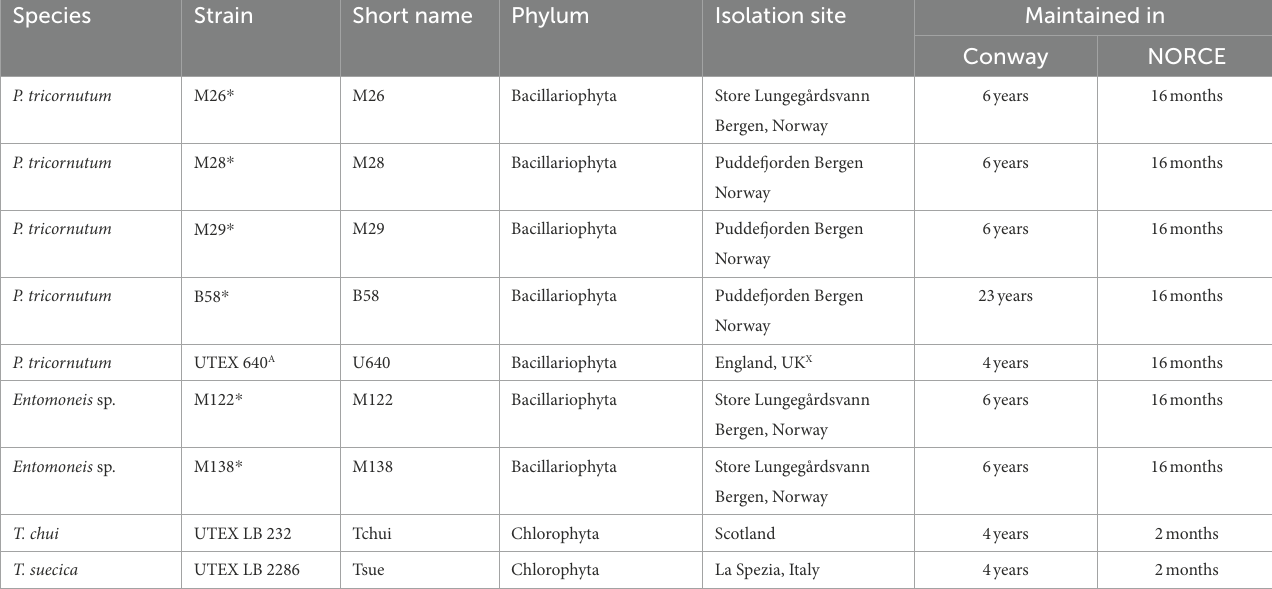
TABLE 1 Overview over stock cultures that were screened for bacterial community composition.